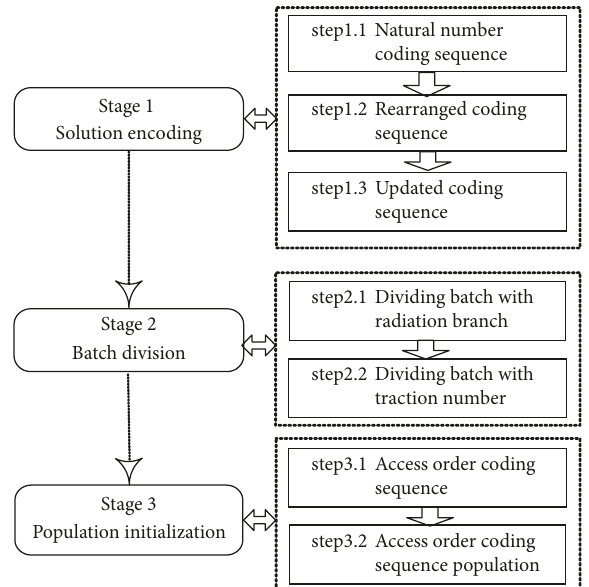
Figure 2: Illustration of the three-phase approach for initial